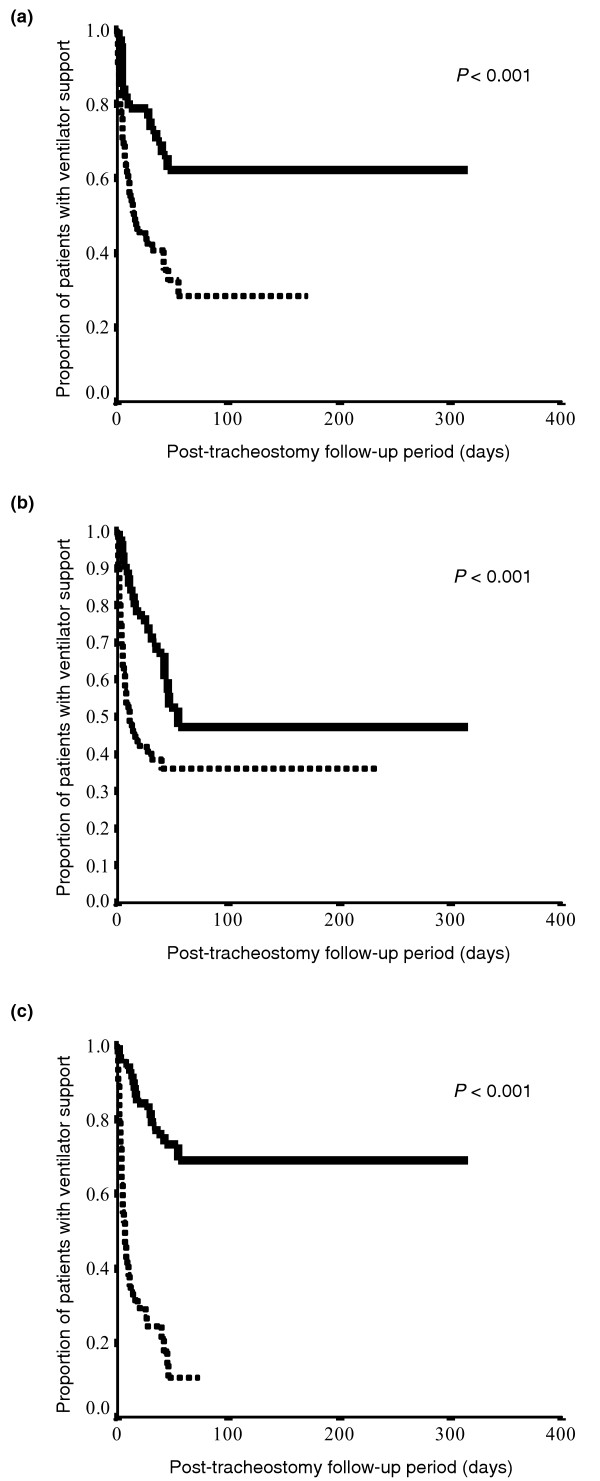
Survival curves of independent predictors of weaning failure. (a) Difference in rates of successful weaning between patients who underwent tracheostomy within 21 days (dotted line) and those who underwent tracheostomy later than 21 days (solid line; P < 0.001). (b) Difference in rates of successful weaning between patients with an arterial oxygen tension (PaO2)/fractional inspired oxygen (FiO2) ratio > 250 (dotted line) and those with a PaO2/FiO2 ratio < 250 (solid line; P < 0.001) before tracheostomy. (c) Difference in rates of successful weaning between the patients with post-tracheostomy pneumonia (solid line) and those without post-tracheostomy pneumonia (dotted line; P < 0.001)